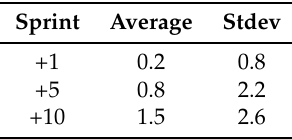
Figure 7. Fit of tickets with S-bugs in the lighting case. Horizontal axes is the time in agile sprints, in this particular case of two weeks, vertical axes shows the total number of bugs with annotation S (high level of severity). Table 3. Predicted number of remaining bugs in the lighting case. Sprints here refers to two weeks development of the